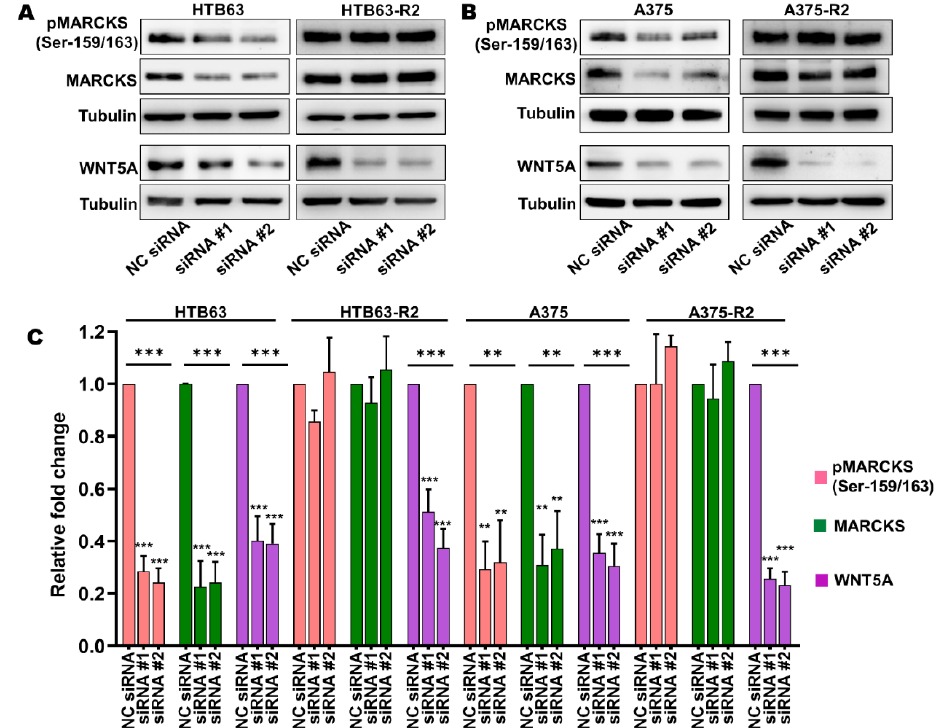
Figure 3. The increased levels of total MARCKS and active phospho-MARCKS are independent of the elevated WNT5A expression in BRAFi-R melanoma cells. ( A , B ) Western blot analysis showing the levels of pMARCKS (Ser-159/163), total MARCKS and WNT5A in BRAFi-sensitive HTB63 and BRAFi-R HTB63-R2 cells ( A ), and in BRAFi-sensitive A375 and BRAFi-R A375-R2 cells ( B ) transfected with negative control siRNA (NC; 50 nM) or either of two different WNT5A-targeting siRNAs (50